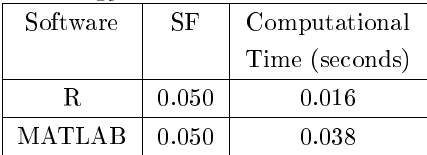
Table 1. Comparison of performance of non-hierarchical algorithm for seven normal PDFs in R and MATLAB